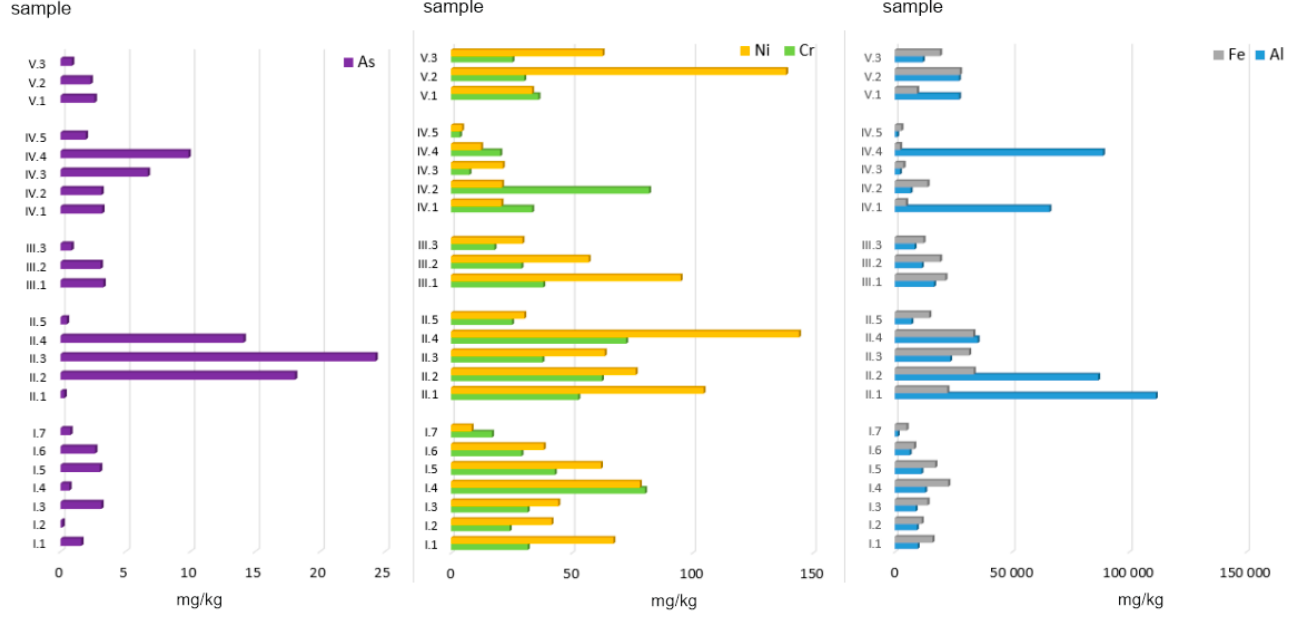
Figure 2. Total concentration of PTEs in ashes burned in a household furnace.